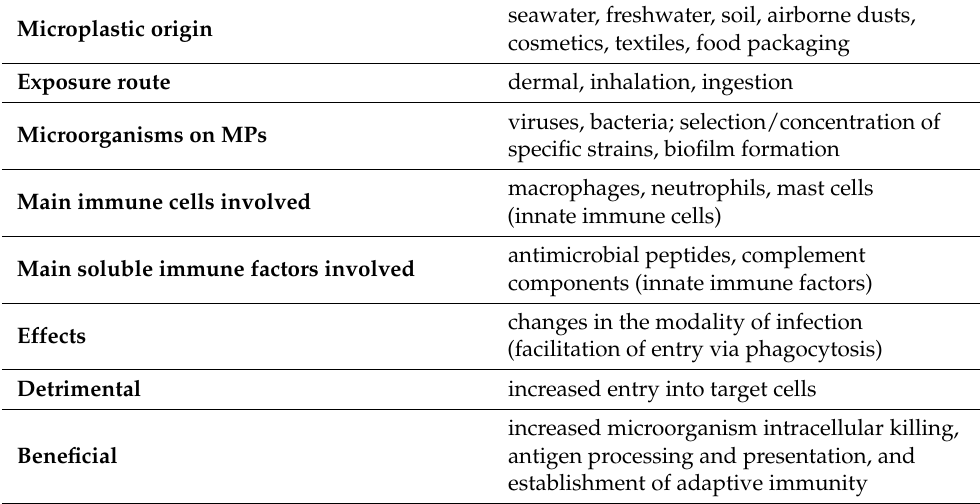
Table 1. Interaction between human immunity and microorganisms carried by microplastics. seawater, freshwater, soil, airborne Microplastic origin